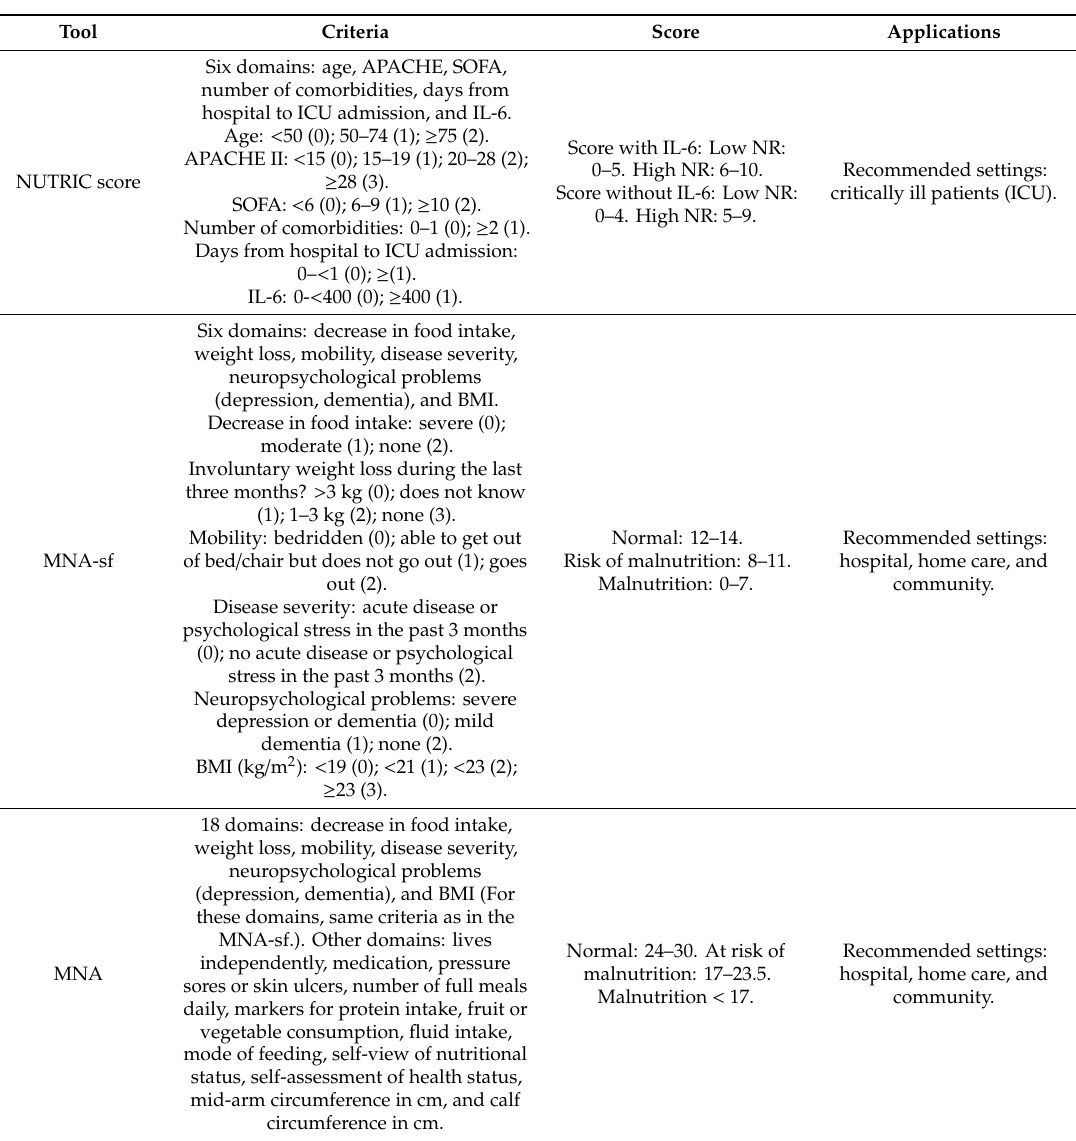
Tool Criteria Score